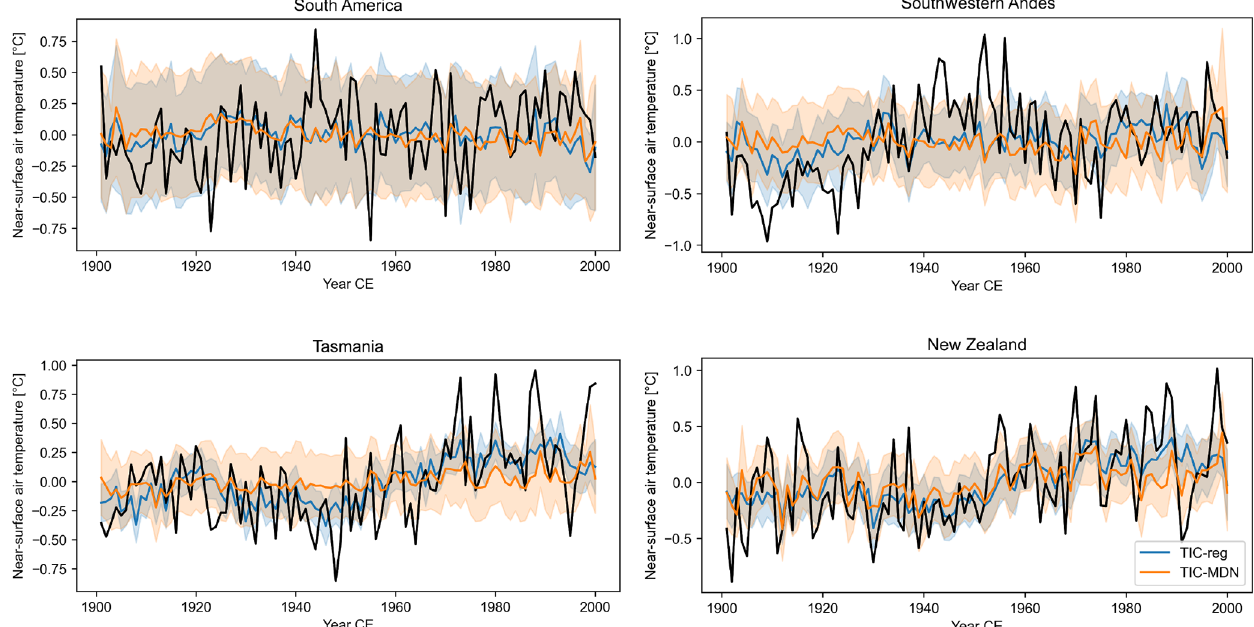
Figure 3. Reconstructed (in color) and GMF (in black) near-surface air temperature anomalies (in ◦ C; relative to 1901–2000CE) over 1901– 2000CE for different DA experiments with both ice core and tree-ring proxies (Table 1) in different regions (Sect. 3). The uncertainty (i.e., the ensemble spread; Sect. 2.1) associated with each reconstruction is represented by the shaded areas.